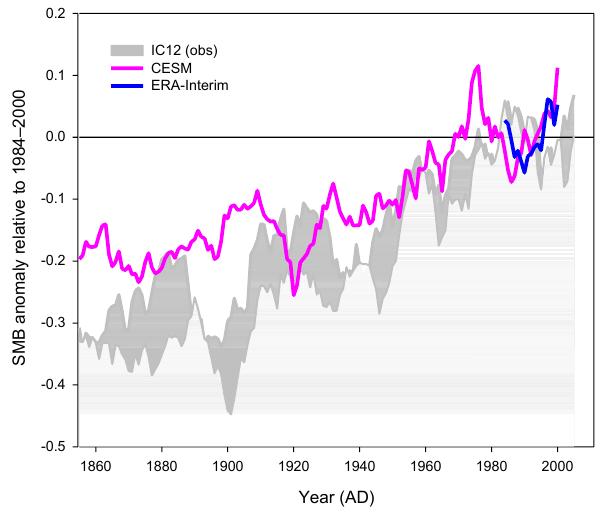
Figure 7. Comparison of SMB trends between IC12 records, with a range between youngest (upper boundary) and oldest esti- mate (lower boundary) shown as grey band, CESM output (pink curve), and ERA-Interim reanalysis (blue curve). All data represent anomaly relative to 1979–1989 (black line) for the overlapping pe- riod 1850–2011.